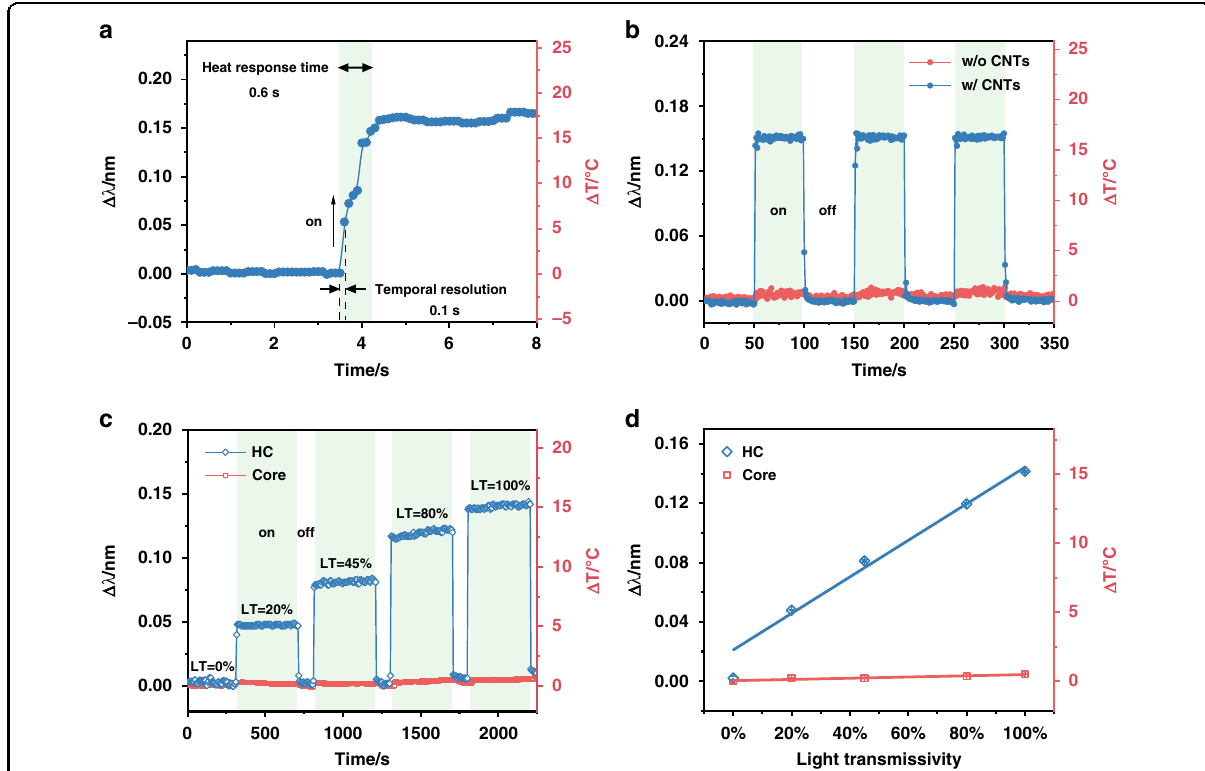
Fig. 5 Quanti fi cation of the temporal response of photothermal effects at the liquid-solid catalyst interface. a , b Wavelength shifts of typical resonances w/ and w/o CNT coating before and after light switch on, showing the response time of light irradiation ( a ) and three cycles with light on/off ( b ). c Real-time wavelength shifts response of HC (99) mode and core mode with increasing light power levels, controlled by fi lters with transmissivities from 0 to 100%. d The linear relationships between the temperature changes for HC and core modes and the light power